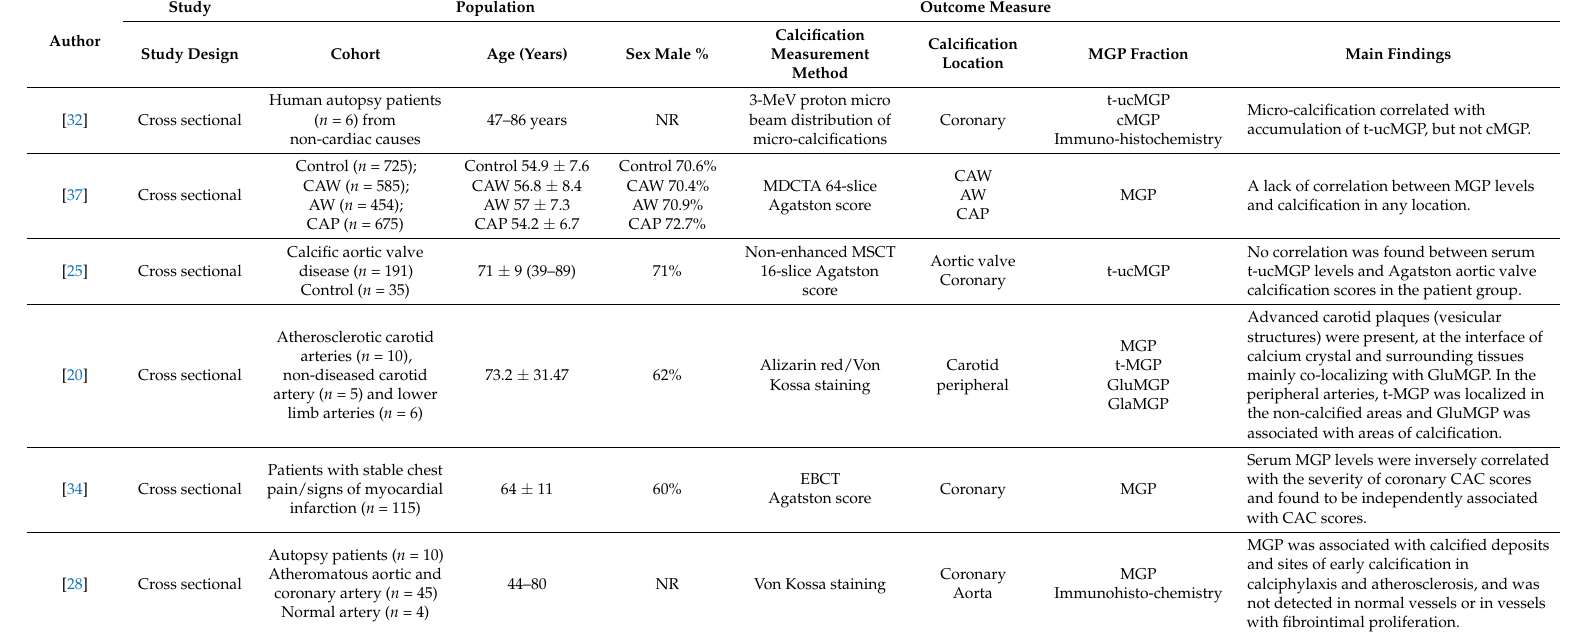
Table 2. Association between MGP fractions and vascular calcification in atherosclerotic cardiovascular disease